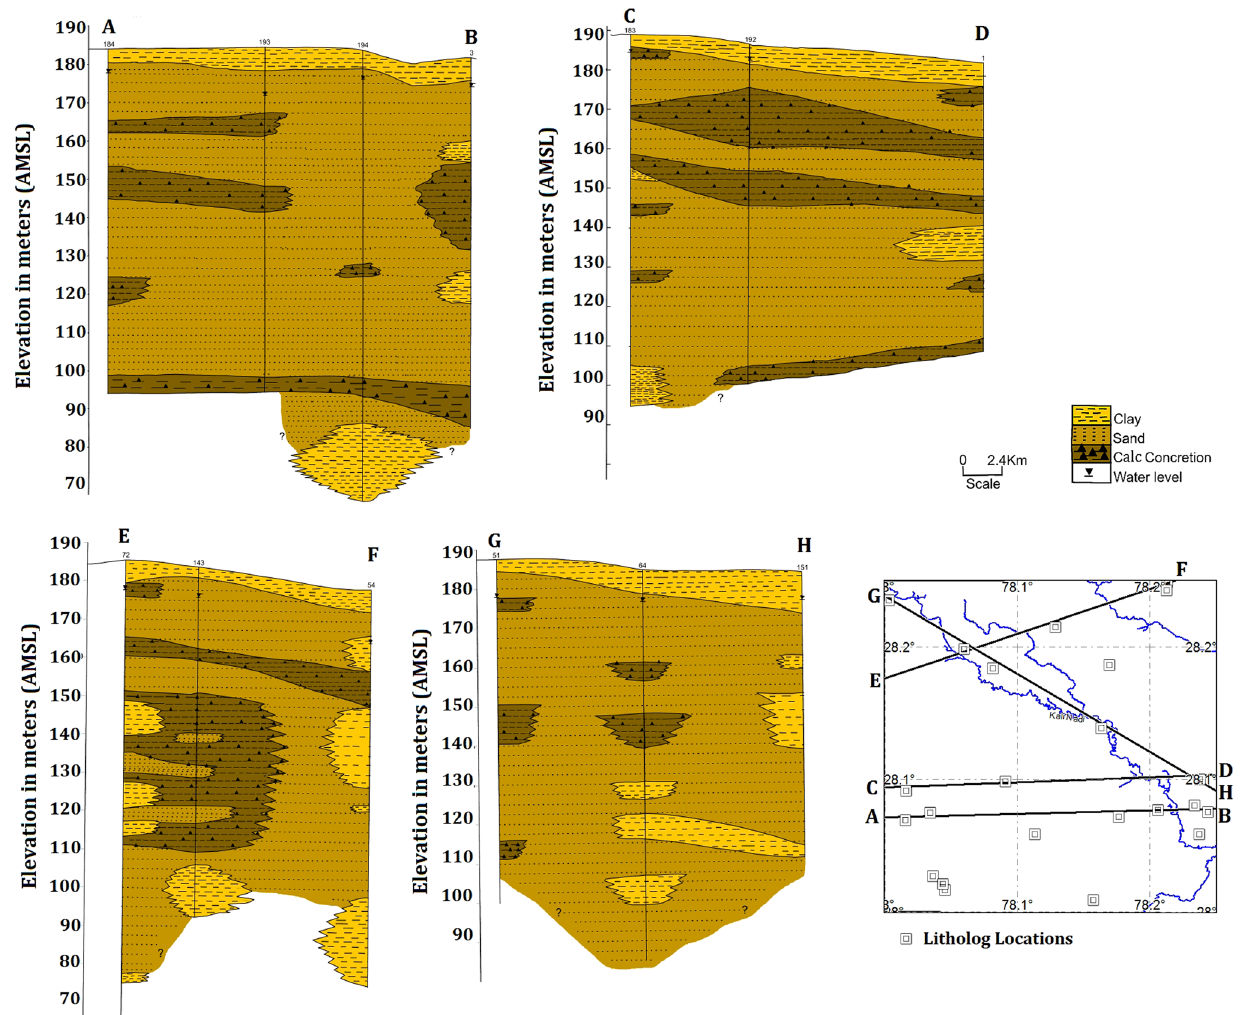
Fig. 2 Hydrogeological section of the aquifer (based on litholog